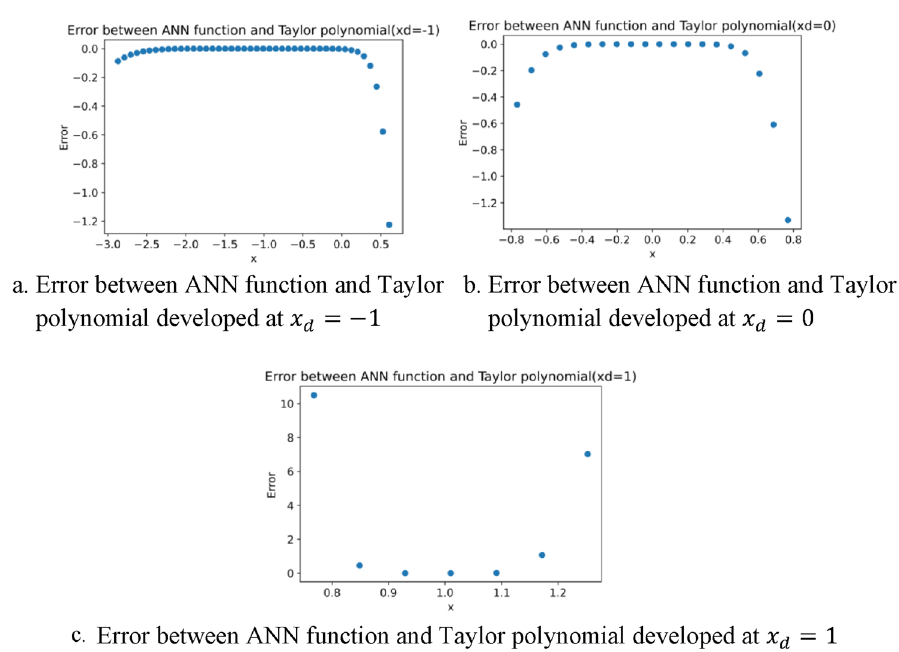
Fig. 6 Error between ANN function and Taylor polynomial using different development